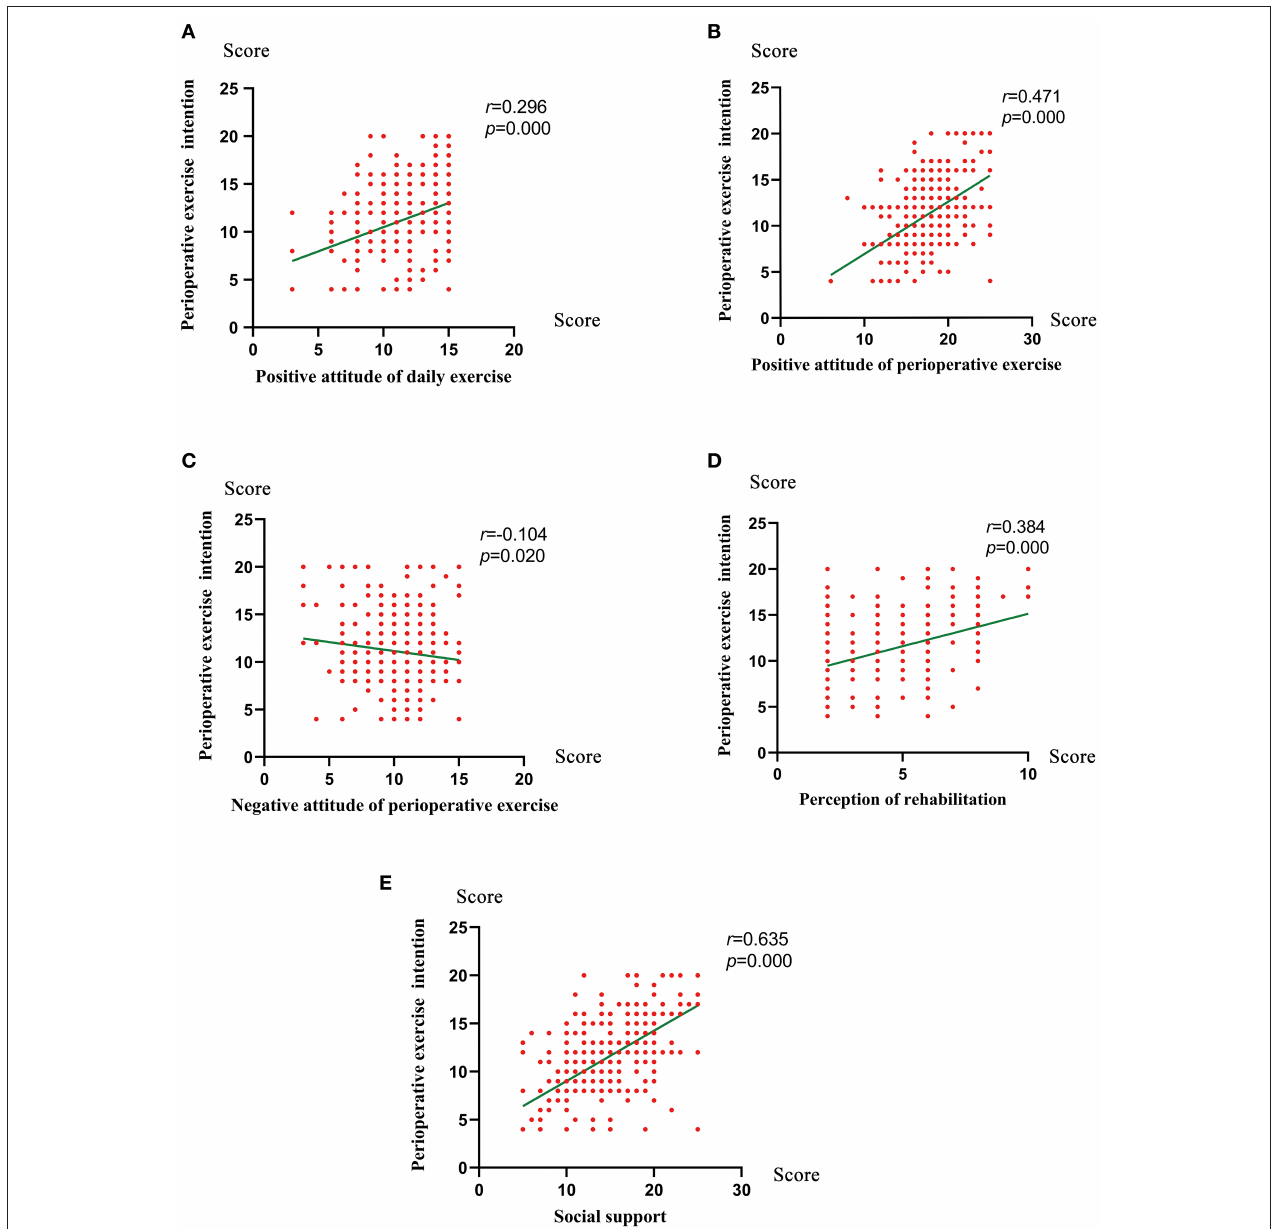
FIGURE 3 | The correlation between the perioperative exercise intention and positive attitude of daily exercise (A) , positive attitude of perioperative exercise (B) , negative attitude of perioperative exercise (C) , perception of rehabilitation (D) , and social support (E) used by Spearman’s tests.